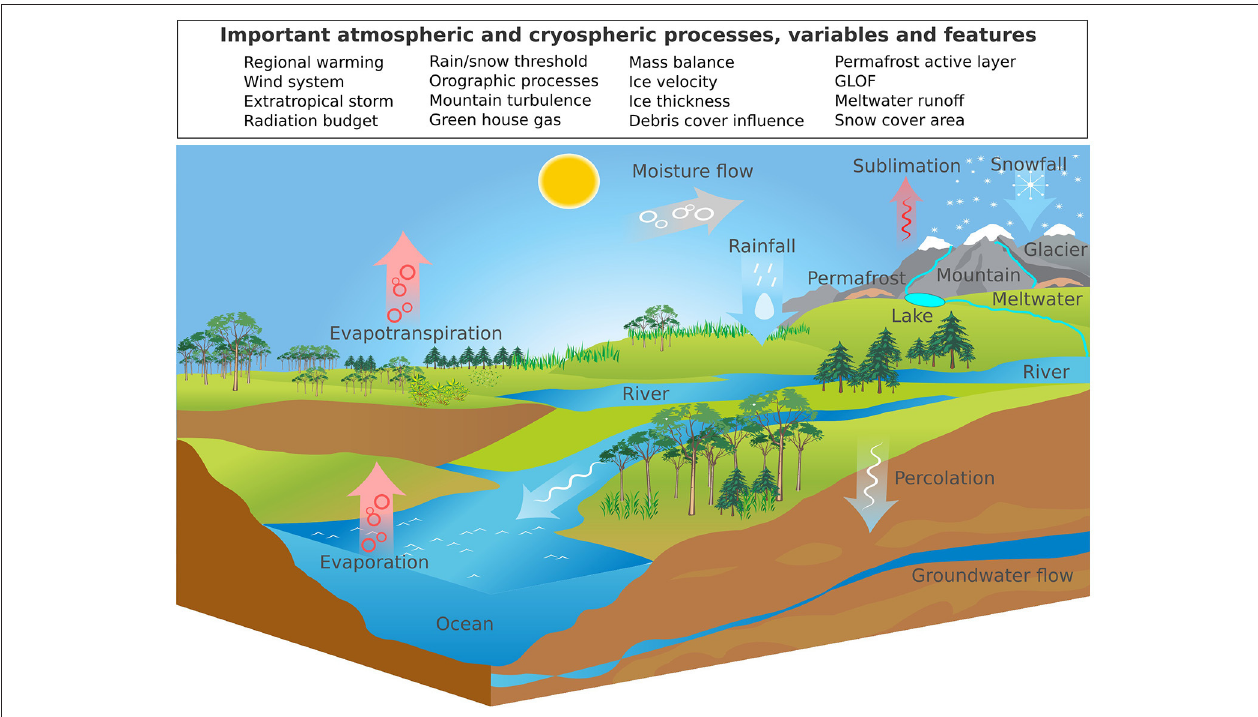
FIGURE 2 | An illustration of simplified hydrological cycle showing the important cryospheric and atmospheric processes, variables and features. The figure is inspired from Azam et al. (2021). Background illustration credit: Nouri